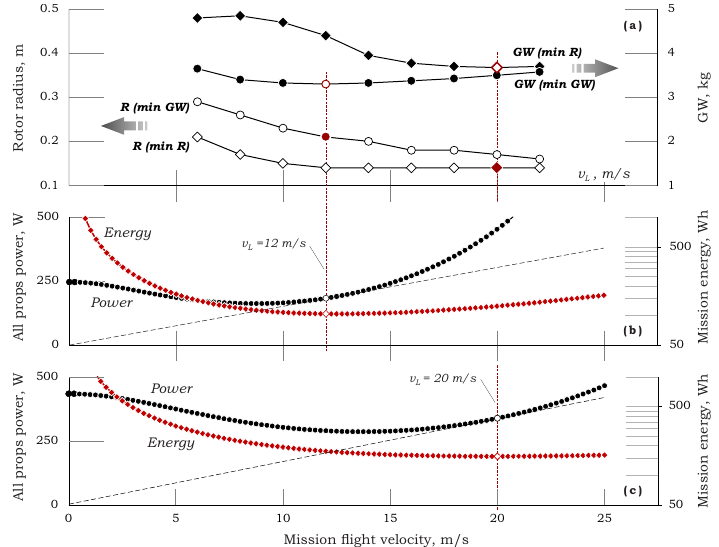
Figure 21. ( a ) Propellers radii and gross-weights; ( b , c ) Power and energy for the “minimum GW vehicle” and the “minimum R vehicle”. All variables are plotted vs. forward flight velocity. Figure 22 is drawn for a mission of forward flight for a range of 20 km only. As shown for a high enough velocity, both “minimum weight” and “minimum radius” collide ( R = 0.13 m, GW = 2.825 kg)—see also Figure 20c.